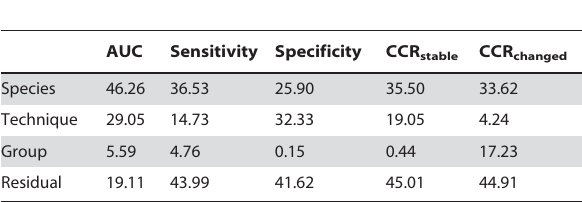
Table 4. Relative effect of taxonomic and methodological variation on accuracy of Figure S1 Accuracy of model hindcasts. The accuracy of hindcasts generated by each modelling framework was measured by mean AUC and reported for each major taxonomic group. Error bars represent 6 1 standard error of the mean. The dashed line indicates the rule-of-thumb for good predictions (AUC = 0.8).